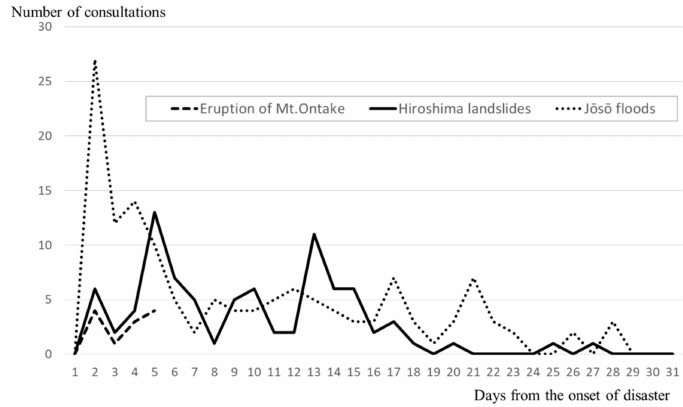
Figure 4. Changes over time in the number of consultations per day for the Mount Ontake eruption, the Hiroshima landslides, and the J¯os¯o floods.